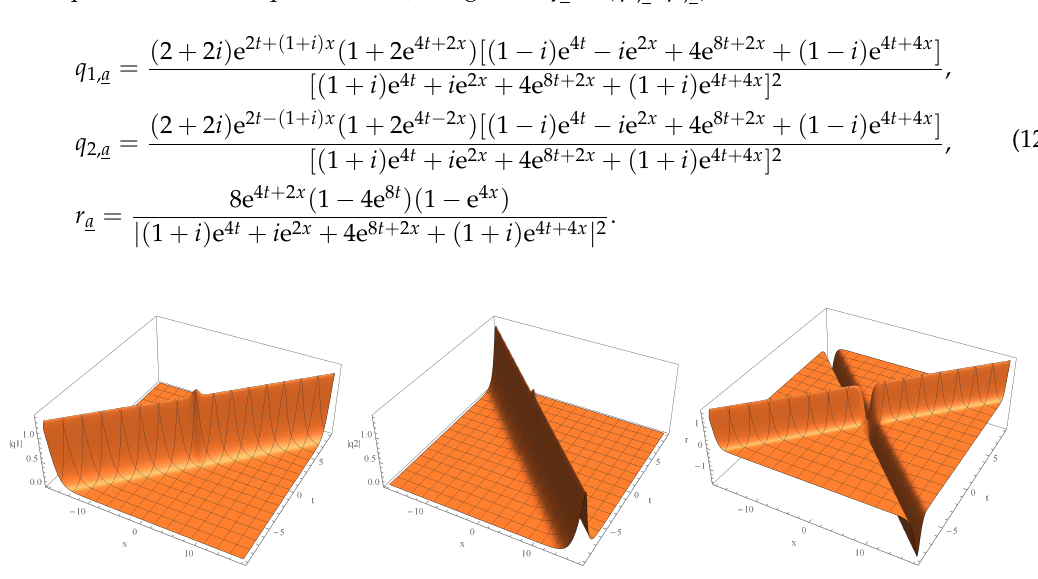
Figure 7. A soliton given by one-fold Darboux